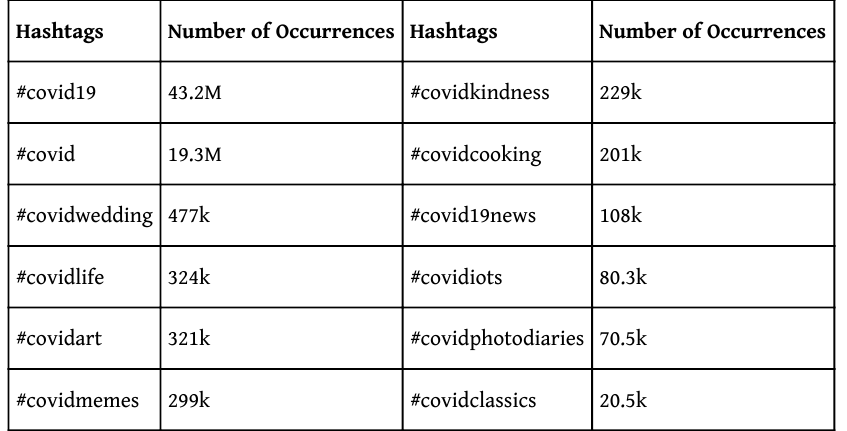
Table 5: Chosen hashtags under the basetag #covid